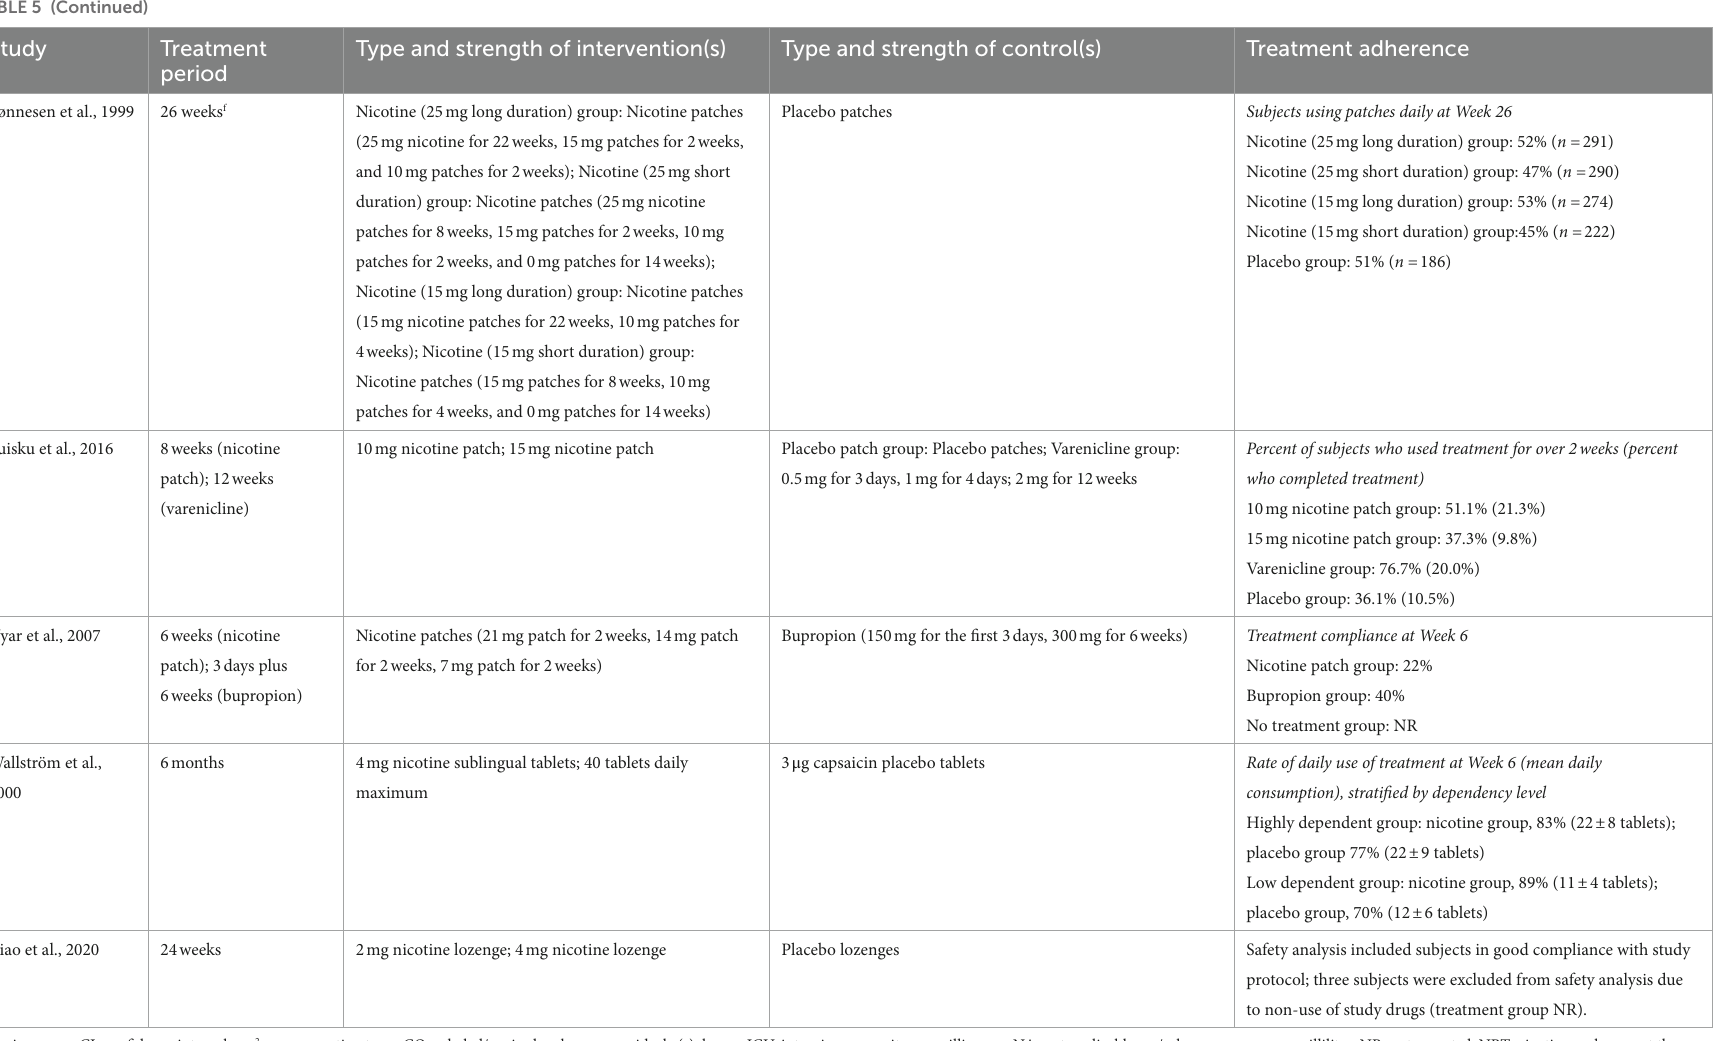
Rate of daily use of treatment at Week 6 (mean daily consumption), stratified by dependency level Highly dependent group: nicotine group, 83% (22 ± 8 tablets);